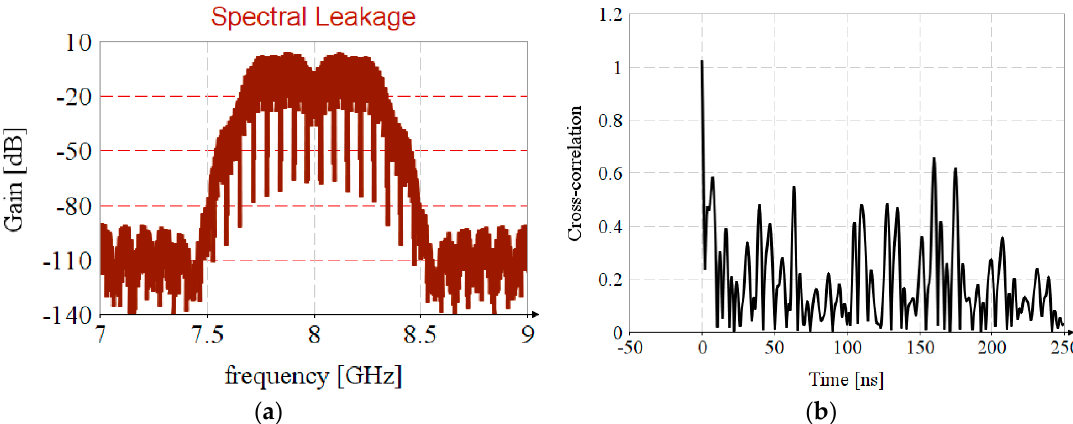
Figure 10. Spectral leakage in timstamp estimation: ( a ) Nonuniformity in CIR estimation; ( b ) Erroneous estimation of timestamp.